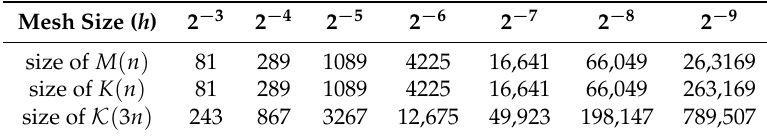
Table 1. Mesh sizes and corresponding sizes of the matrices.